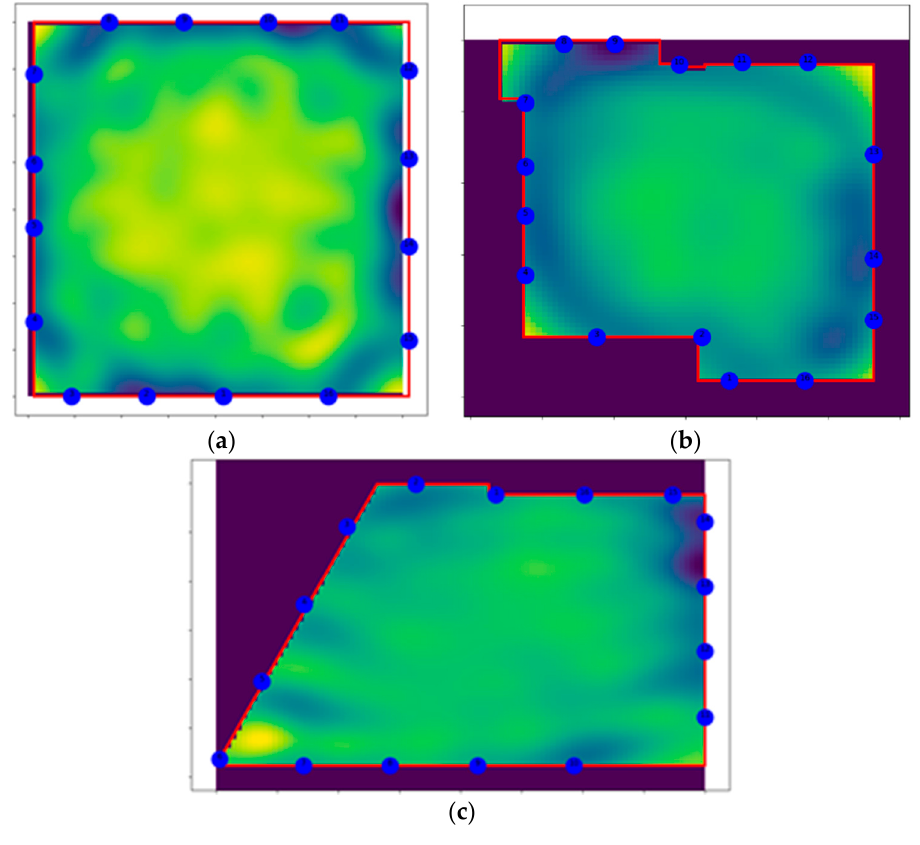
Figure 9. A test and real models of separate measurement zones subjected to radio tomography: ( a ) square-shaped, ( b ) actual room number 1, ( c ) actual room number 2.